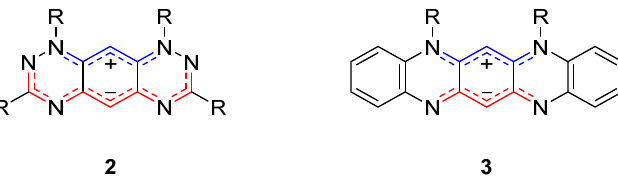
Figure 1. General structure of biscyanines 2 and 3 prepared from difluorodinitrobenzene 1 [20–25].